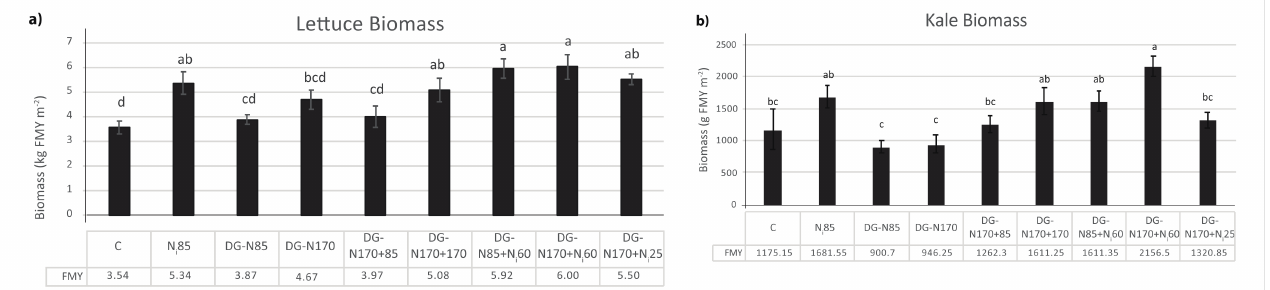
Figure 1. Biomass production of ( a ) lettuce (kg FMY m − 2 ) and ( b ) kale (g FMY m − 2 ). According to Duncan’s multiple range test, different letters above the columns indicate statistically significant differences among the treatments ( p < 0.05). The data are presented as mean ± SE (n =